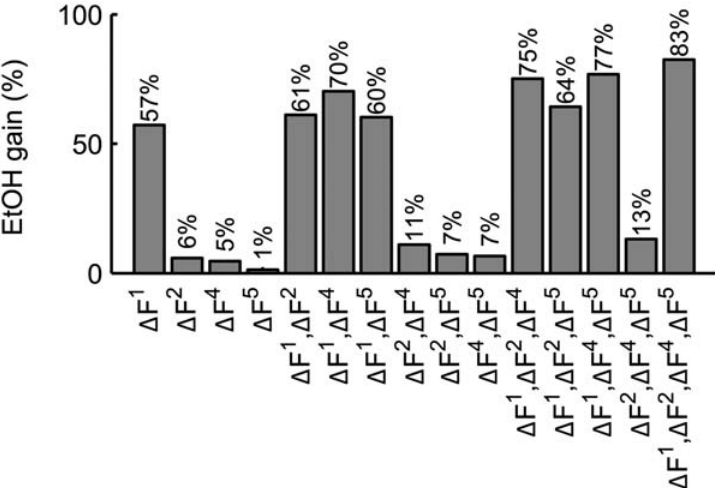
Fig 12. Potential ethanol production gains by knock-outs of functionalities. The bars represent the potential gain in ethanol production for a mixed flow glucose concentration of 10 mM if one or more of the EFMs are knocked out, e.g. by gene deletions of corresponding enzymes. These values can be directly obtained from the respective steady-state extracellular ethanol concentrations in the layers in the layering graph. For example, the expected gain for knocking out functionalities F 1 and F 4 corresponds to − L EtOHX ( F 1 , F 0 ) as t !1 . Note that for some knock-outs the resulting networks become unstable F 4 j F 0 , F 2 , F 3 , F 5 )/ L EtOHX ( (see main text), although not in the concentration of